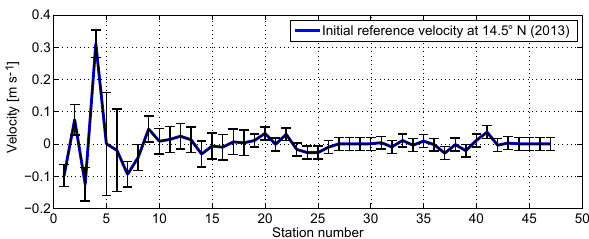
Figure 7. Initial reference velocity with error bars for the 2013 re- alization at 14.5 ◦ N, estimated from a combination of SADCP and LADCP (see text for